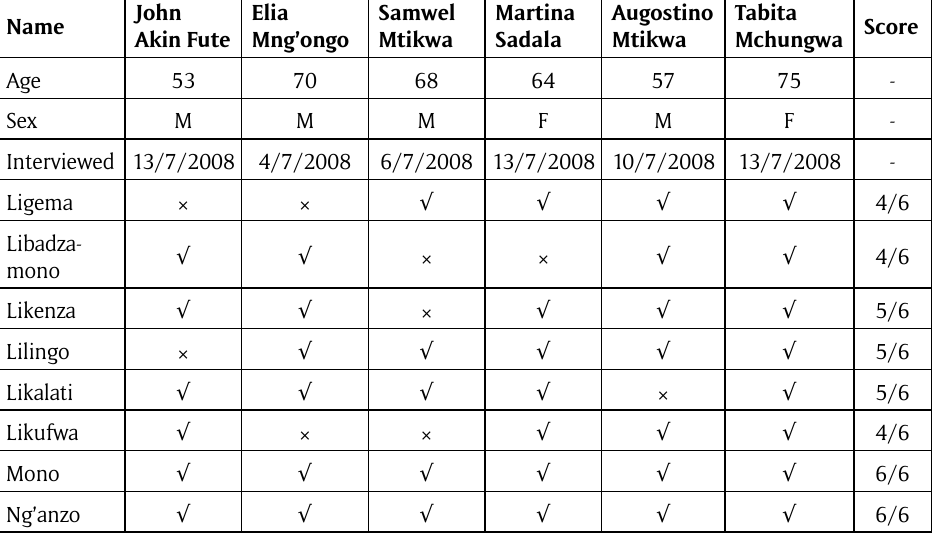
Table 3: List of the informants (Phase I). Note that all informants were the sons or grandsons and daughters or granddaughters of some of the renowned smelters of